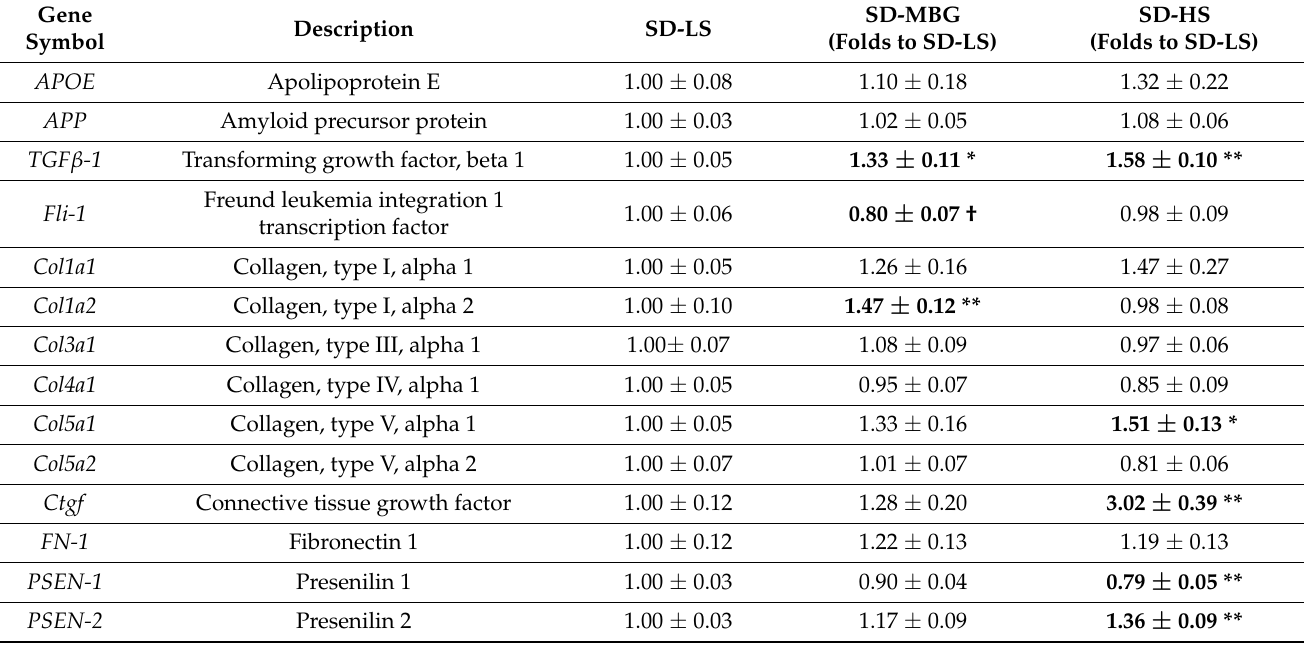
Table 4. Expression of fibrosis-associated genes and other genes in the left ventricles of Sprague– Dawley (SD) rats treated with MBG or HS vs. LS control assessed by